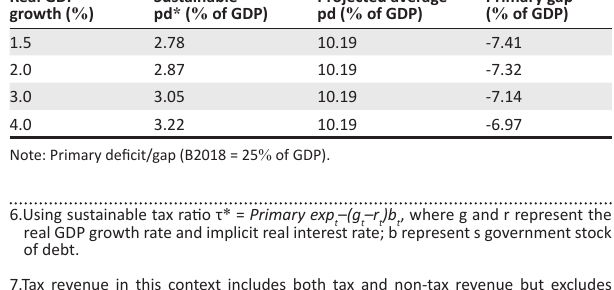
FIGURE 4: Law of motion for the debt dynamics.